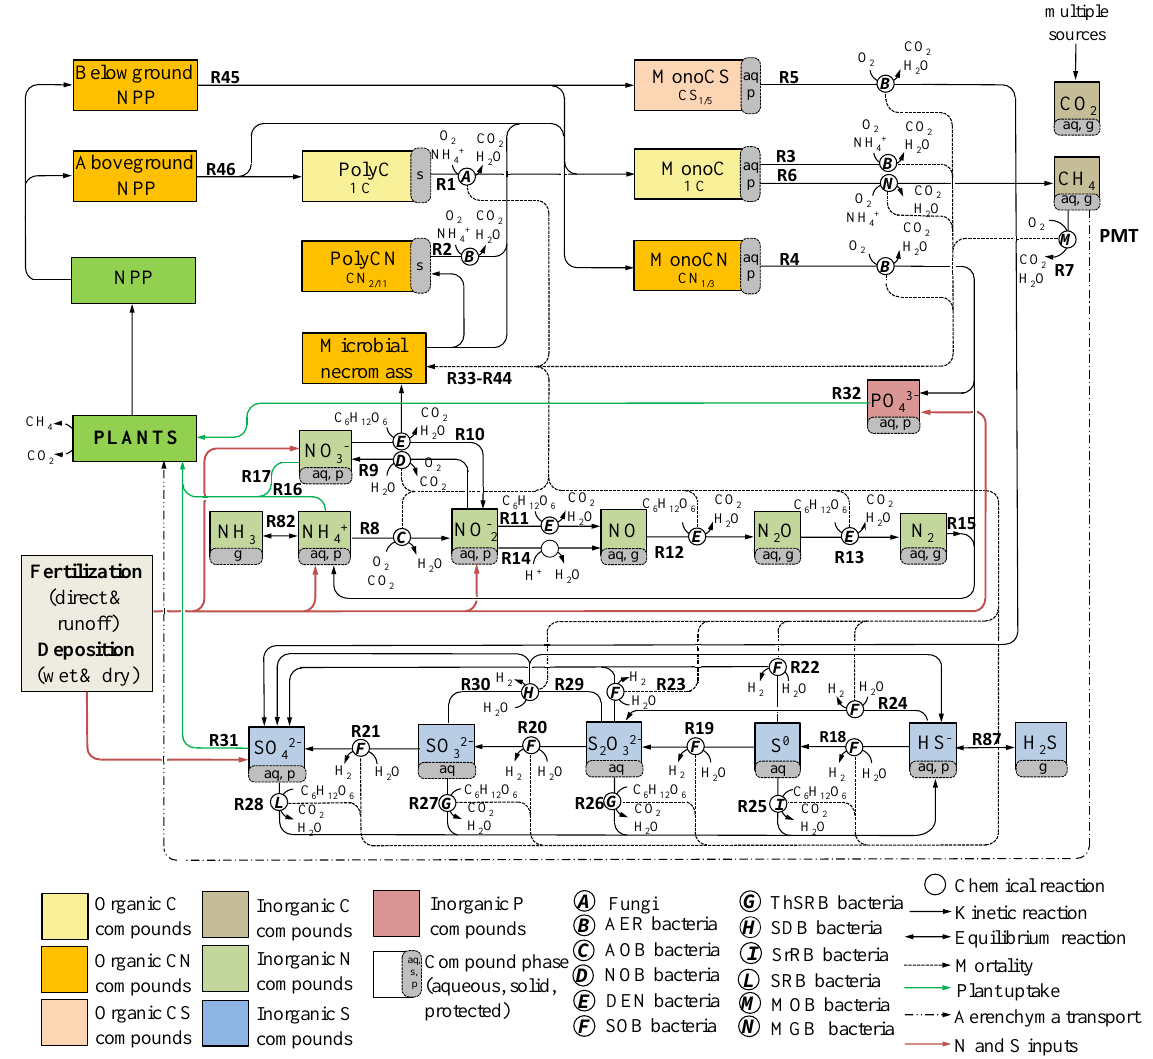
Figure 1. Biotic and Abiotic Model for SOM–version 4 (BAMS4) biogeochemical reaction network. RX and A-N identify each reaction and microbial functional group, respectively. Refer to Tables S1–S6 in the Supplementary Information for each reaction